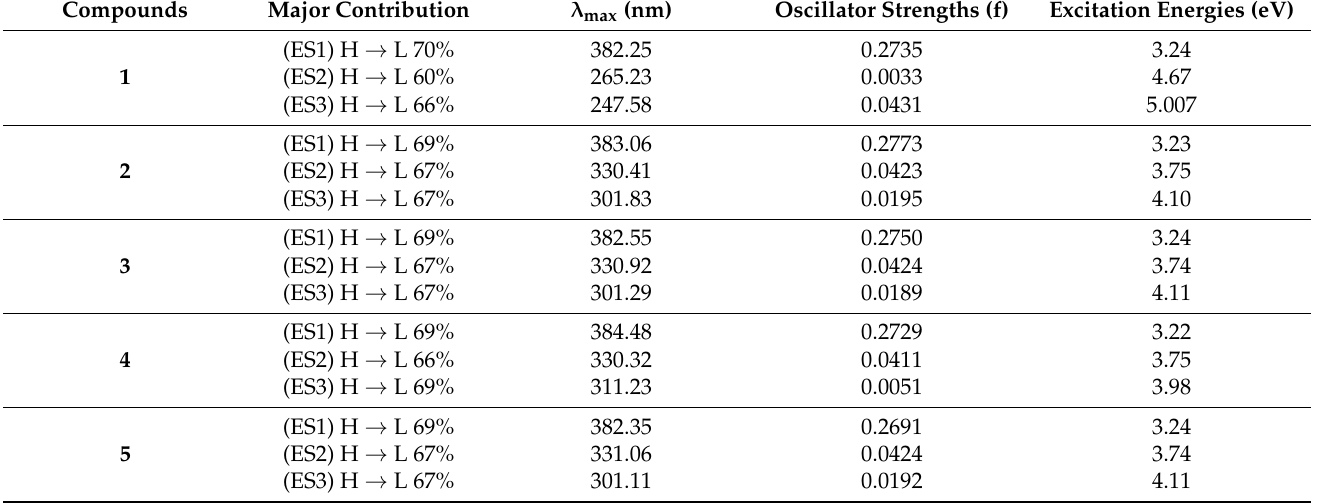
Table 4. Theoretically calculated absorption wavelengths ( λ max ), oscillator strengths (f) and excitation energies (E) of all the studied compounds. The abbreviations ES1, ES2 and ES3 indicate the first, second and third excitation